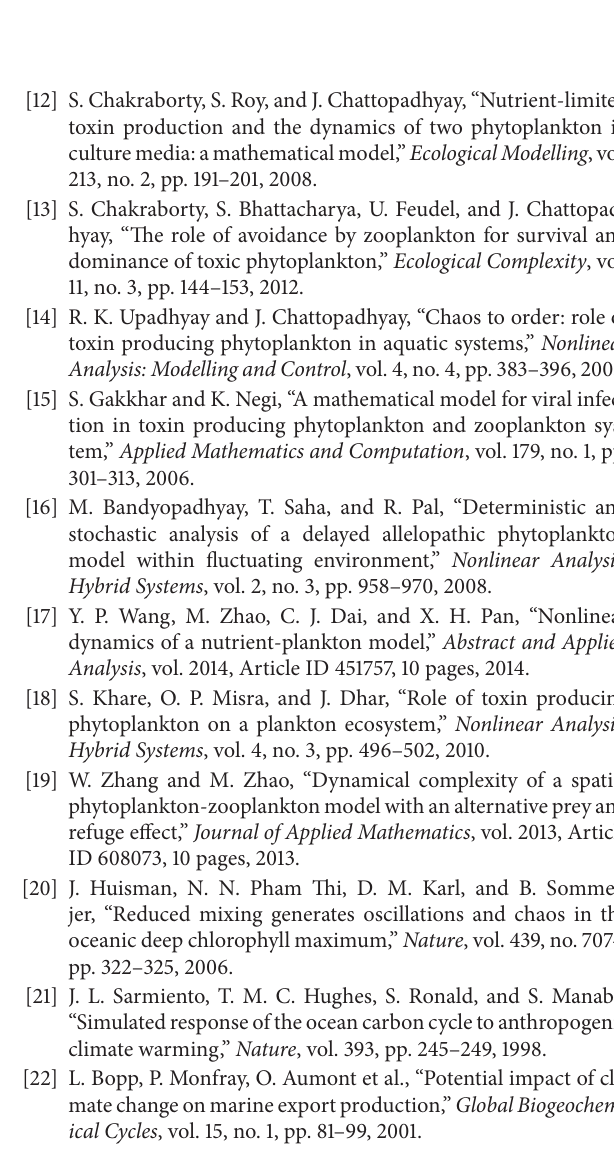
= 3.5 . (b) 𝐷 = 0.4 , 𝐷 = 0.1 ; (c) 𝐷 = 0.91 , 𝐷 = −0.5 . Time steps: (a) 0, 22 21 12 21 12